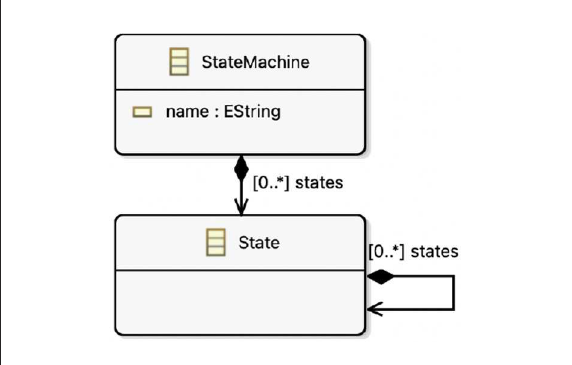
FIGURE7 DSML A . *Unbounded upperbound for cardinalities.